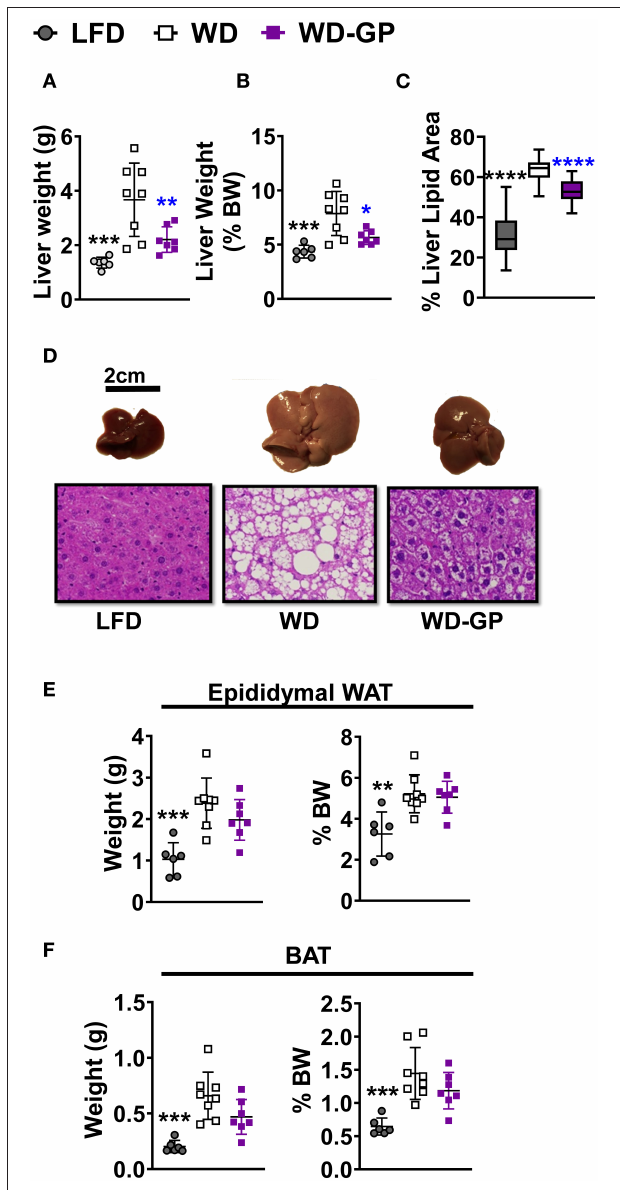
FIGURE 3 | GP supplementation diminished WD-induced hepatic steatosis. (A) Liver weights at endpoint, after 23 weeks of diet-intervention, (B) Liver weight as a percentage of body weight. (C) Mean percentage of liver coverage by lipid droplets per cross-section, as quantified from hematoxylin and eosin (H&E) staining ( n = 3/group); (D) Representative images of murine livers from each diet group with corresponding H&E-stained liver sections (below) showing white lipid droplets; images were captured at 40 × magnification. Organ weights as raw weight (left panel) and as percent of body weight (right panel) of (E) white adipose tissue (WAT), and (F) brown adipose tissue (BAT) on day of euthanasia (week 24 of diet-intervention). Data are presented as mean ± SD. Significant differences between groups were determined by one-way ANOVA followed by Dunnett’s multiple comparisons test with the WD group as control. Black colored asterisks indicate statistical significance between the LFD vs. WD group and blue-colored asterisks indicate statistical significance between the WD vs. WD-GP group. * p < 0.05, ** p < 0.01, *** p < 0.001, **** p < 0.0001. BW, Body